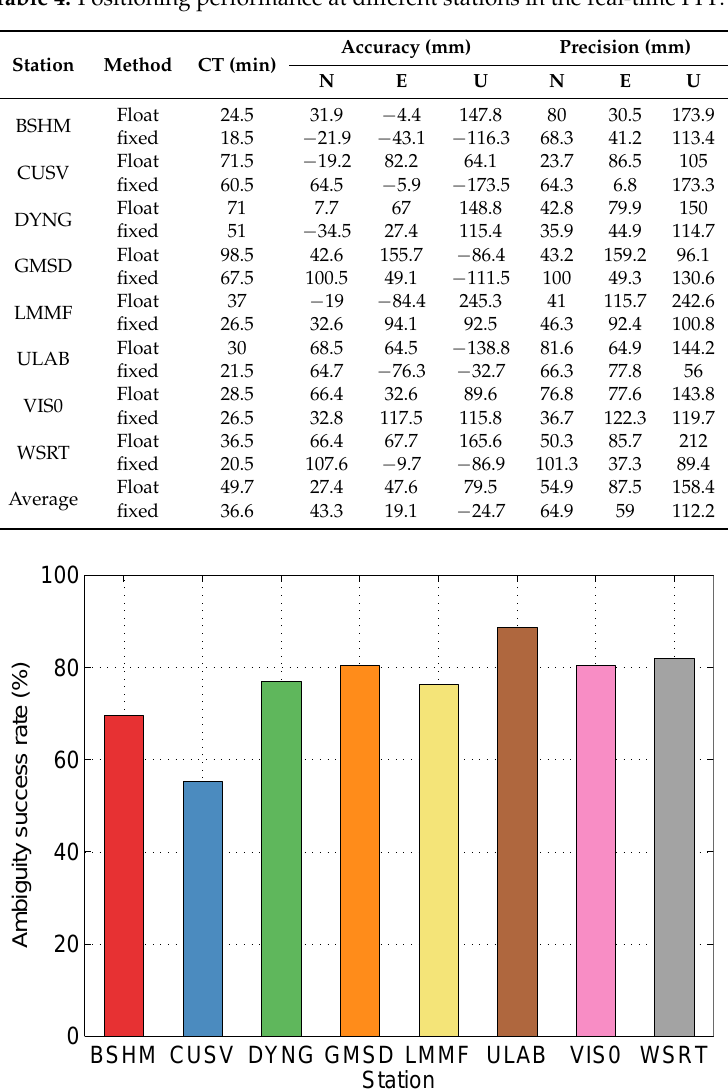
Figure 17. The ambiguity success rates at different stations in the real-time